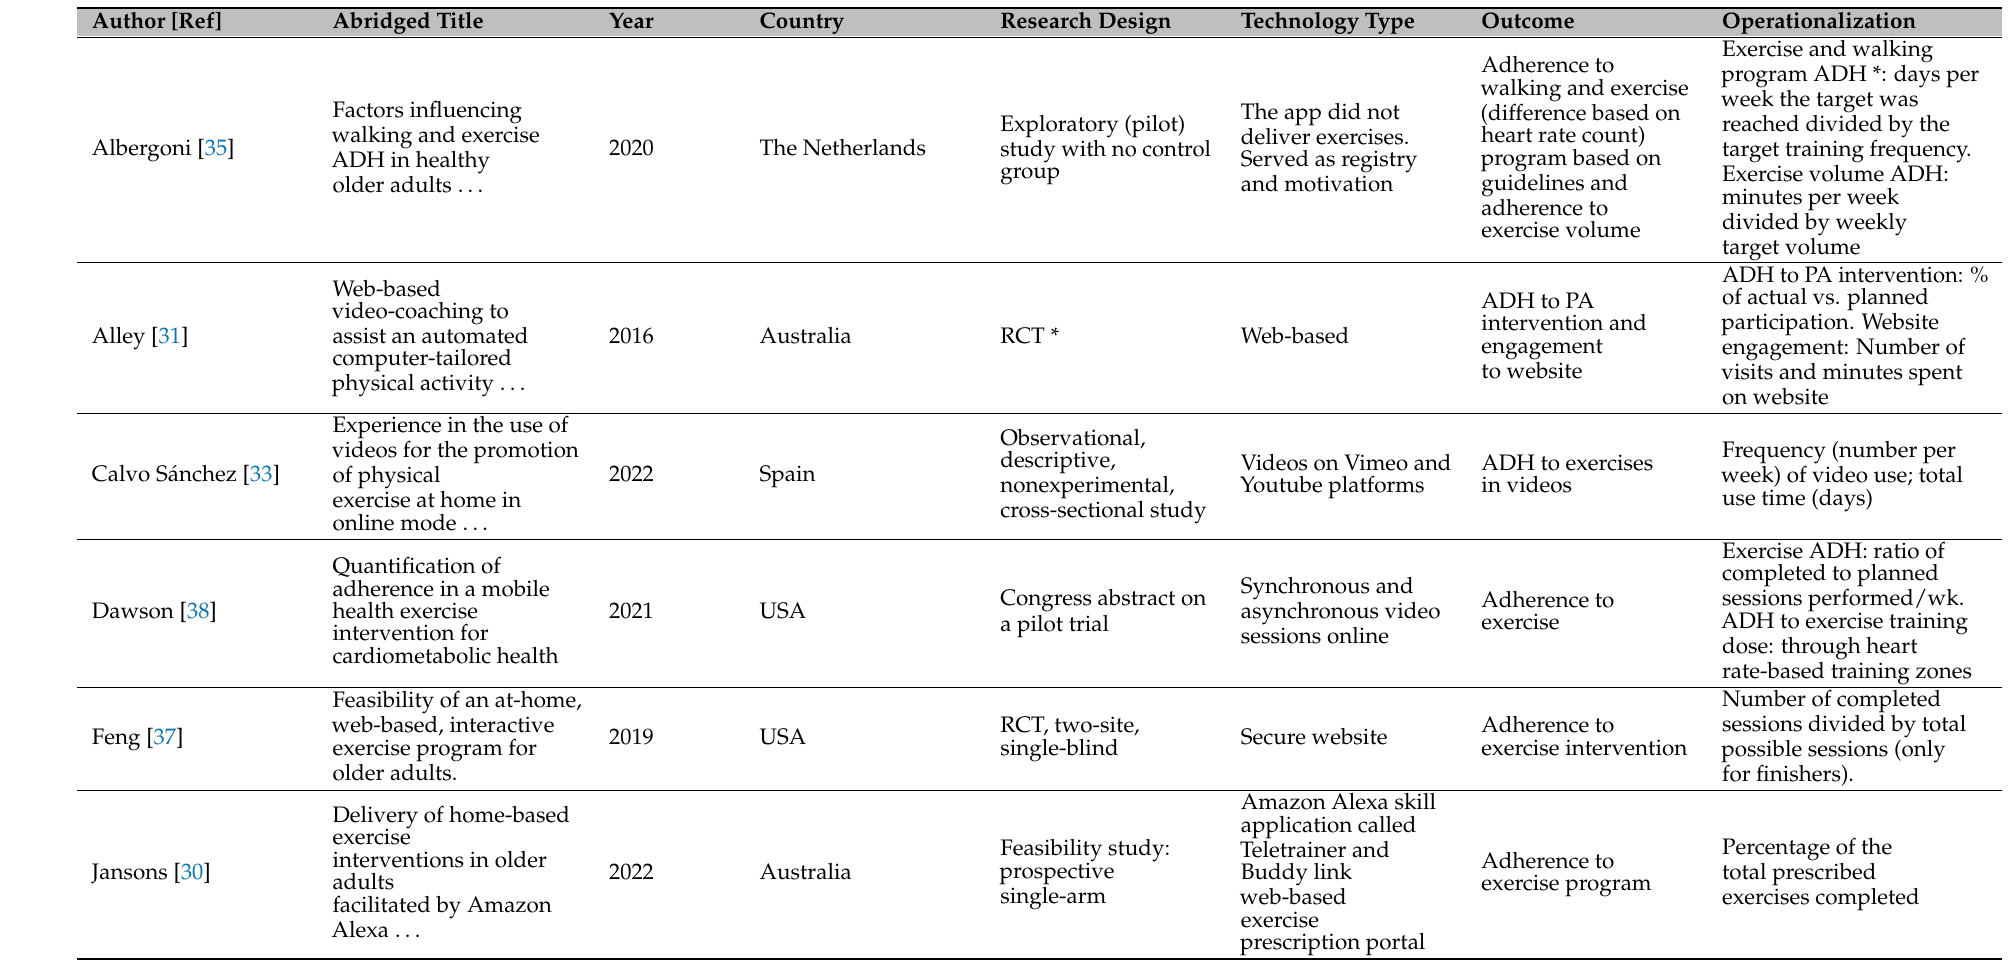
Table 1. Scoping review matrix used for the collection of publication data from the reviewed